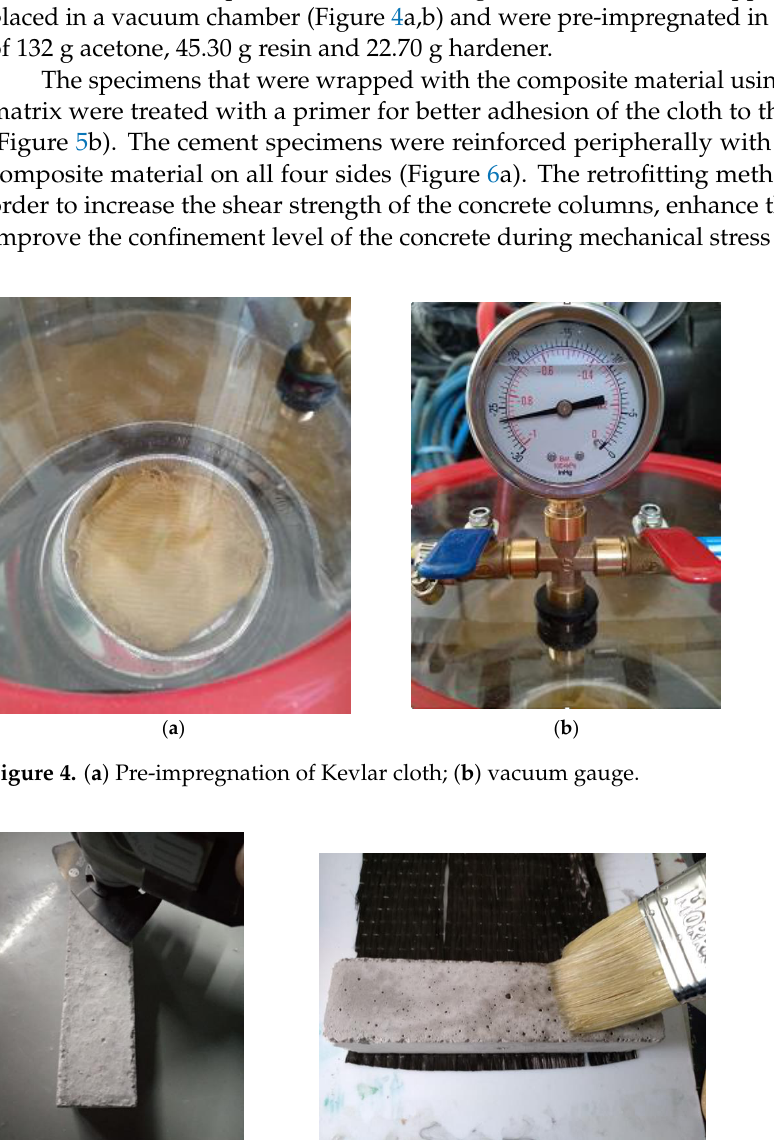
Figure 3. ( a ) Three-gang mold for 40 × 40 × 160 mm cement specimens; ( b ) 28-days hydration of cement specimens; ( c ) cement specimen.